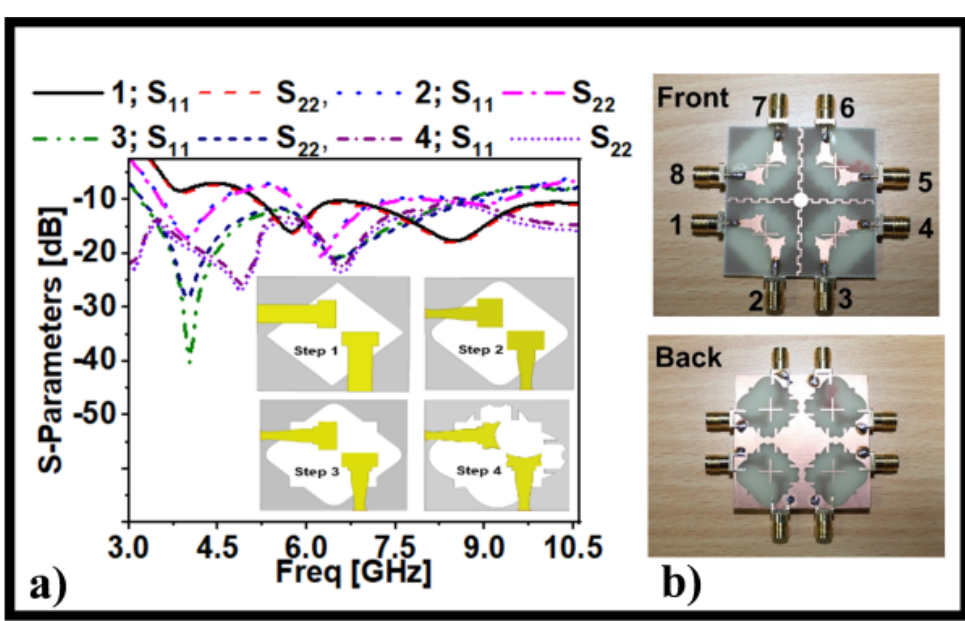
Figure 1. Design methodology and fabrications: ( a ) step-by-step design evolution; ( b ) fabricated view (top = front side; bottom = back side).